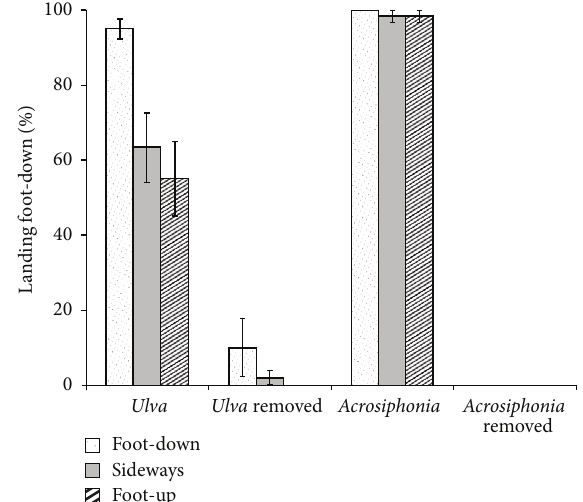
Figure 1: Percentage of trials in which limpet landed foot-down on the tank bottom when dropped from the three starting orientations. Data are means ± standard